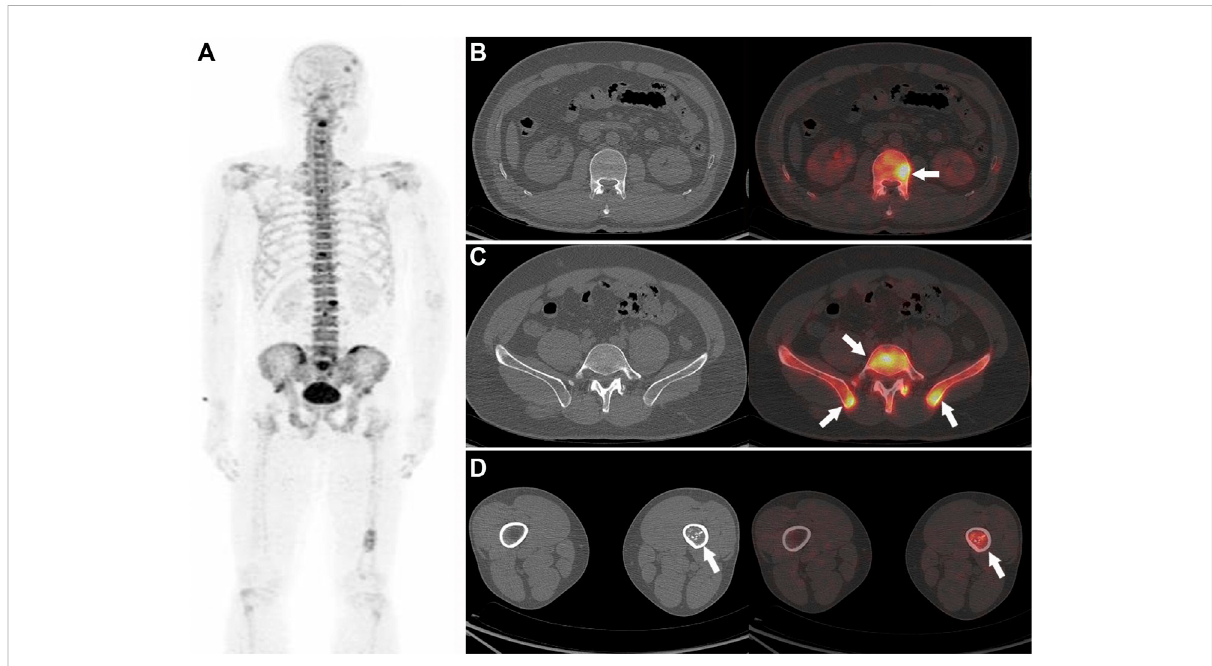
FIGURE 4 Nasopharyngeal carcinoma (T3M3M1) in a 42-year-old male patient. The PET MIP (A) shows multiple 18 F-NaF uptakes in the skull, spine, pelvis, andthelefttibia. Multiple abnormal 18 F-NaFuptakes inthespine (B) , arrowandpelvis (C) , arrow, noabnormalmorphologychangescanbeobserved inthecorrespondingCT,werediagnosedasbonemetastases(correctlyaccordingtothereferencestandard).Amildabnormal 18 F-NaFuptakeinthe left tibia (D, arrow), and a heterogeneous increase in density in the corresponding CT (D) , which were diagnosed as abnormal bone fi bre proliferation disease (correctly according to the reference